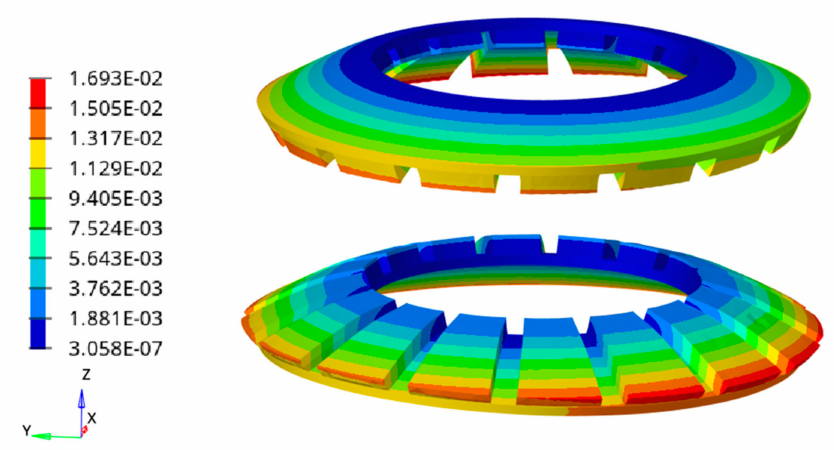
Figure 15. The deformed geometry’s displacements (mm) of the rotor discs at 1531 Hz.